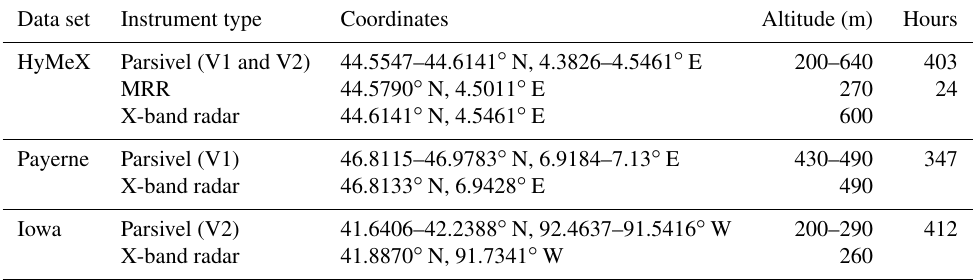
Table 1. Summary of instrument networks used. Coordinates for Parsivel networks are bounding boxes. Altitude is above sea level to nearest 10m. Hours are provided only for non-instantaneous measurements and show total hours of rain data measured by each